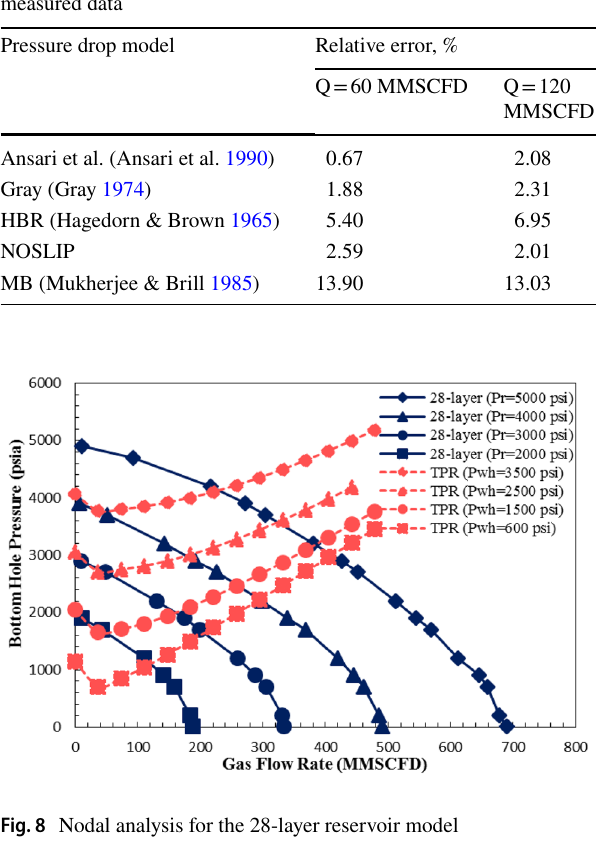
Fig. 8 Nodal analysis for the 28-layer reservoir model